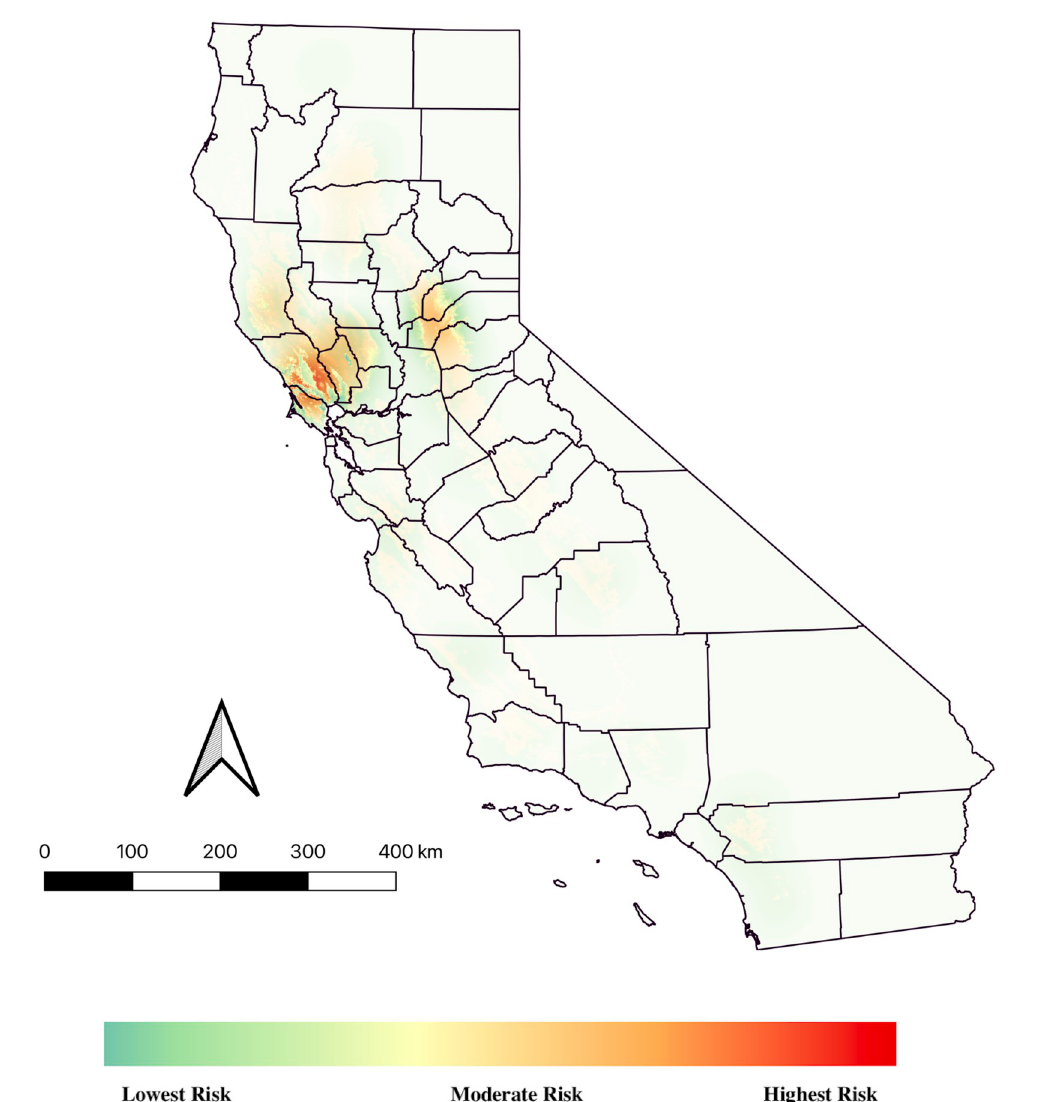
Fig 4. Risk map demonstrating areas in California at greatest risk for contact between feral pigs and outdoor-raised domestic pigs within a 5km radius from each farm, using the Kernel Density tool in QGIS. Colors are based on the probability of suitable feral pig habitat from the final MaxEnt model at each OPO, with sharper colors representing denser clustering of OPO.